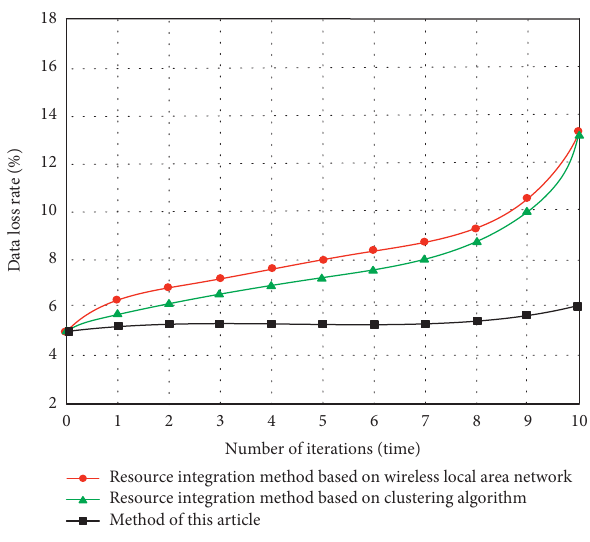
Figure 5: Data loss rate test results.